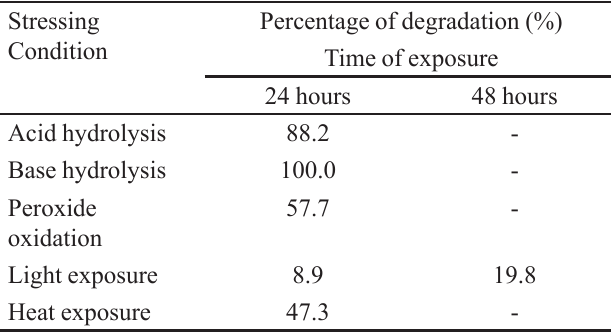
TABLE III - Time of exposure of samples to forced degradation